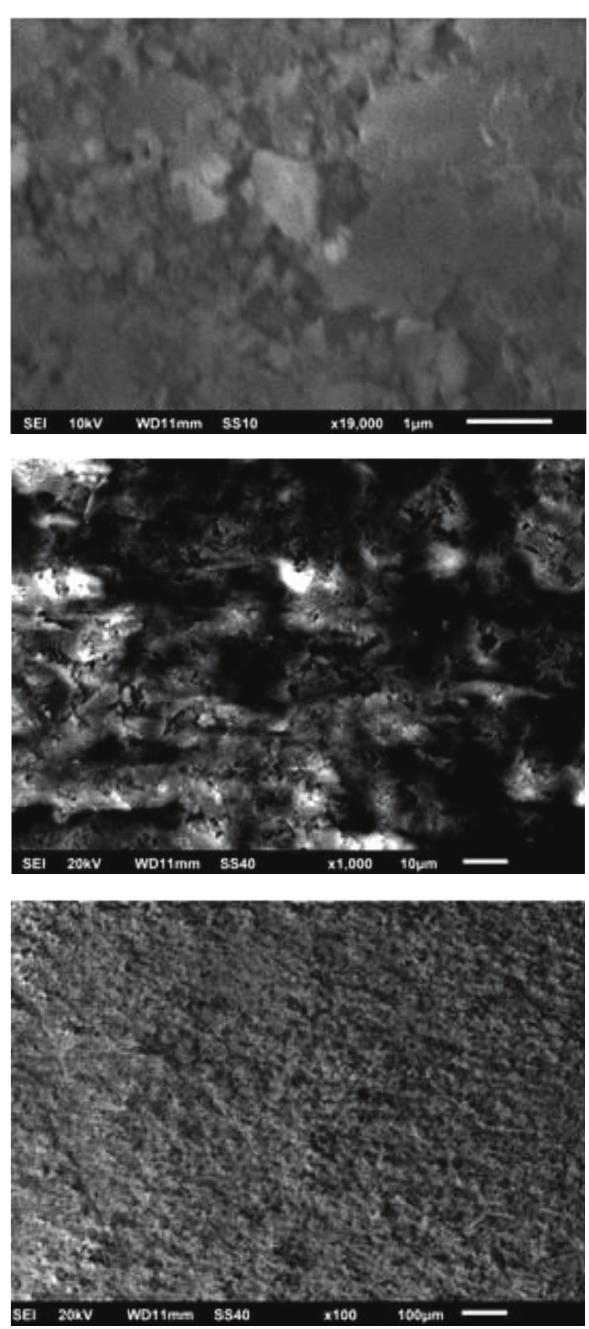
Fig. 7 – SEM images of catalyst Rh-Pt (9:1)/Al